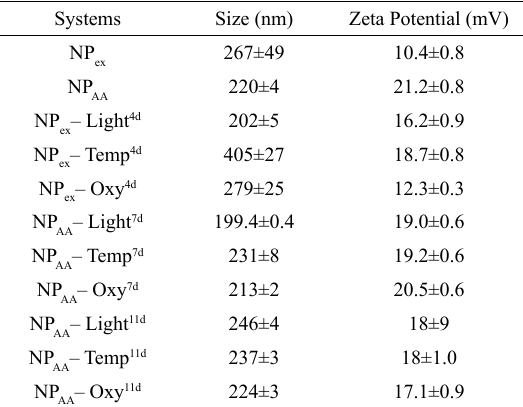
Figure 1. Variation of vitamin C concentration (normalized) in function of storage time for AA when exposed to a) light at 25 ºC; b) temperature of 35 ºC in absence of light and c) O Table 3. Variation in size and zeta potential for NP different storability conditions as light, temperature and oxygen. The indices ‘4d’, ‘7d’ and ‘11d’ indicate the number of days stored under these conditions.